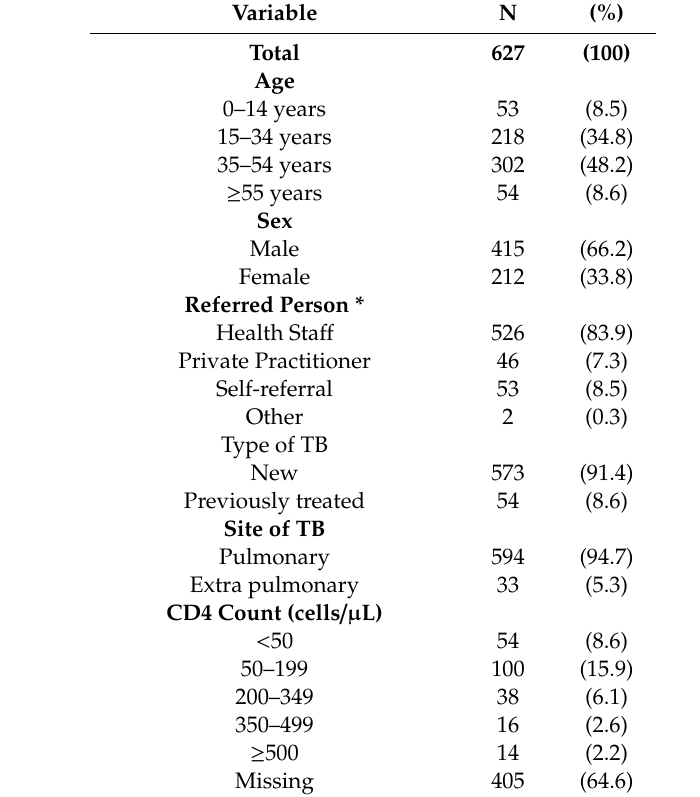
Table 1. Demographic and clinical characteristics of HIV-infected TB patients registered in the public health facilities of Ayeyawady Region of Myanmar, between July 2017 and June 2018.